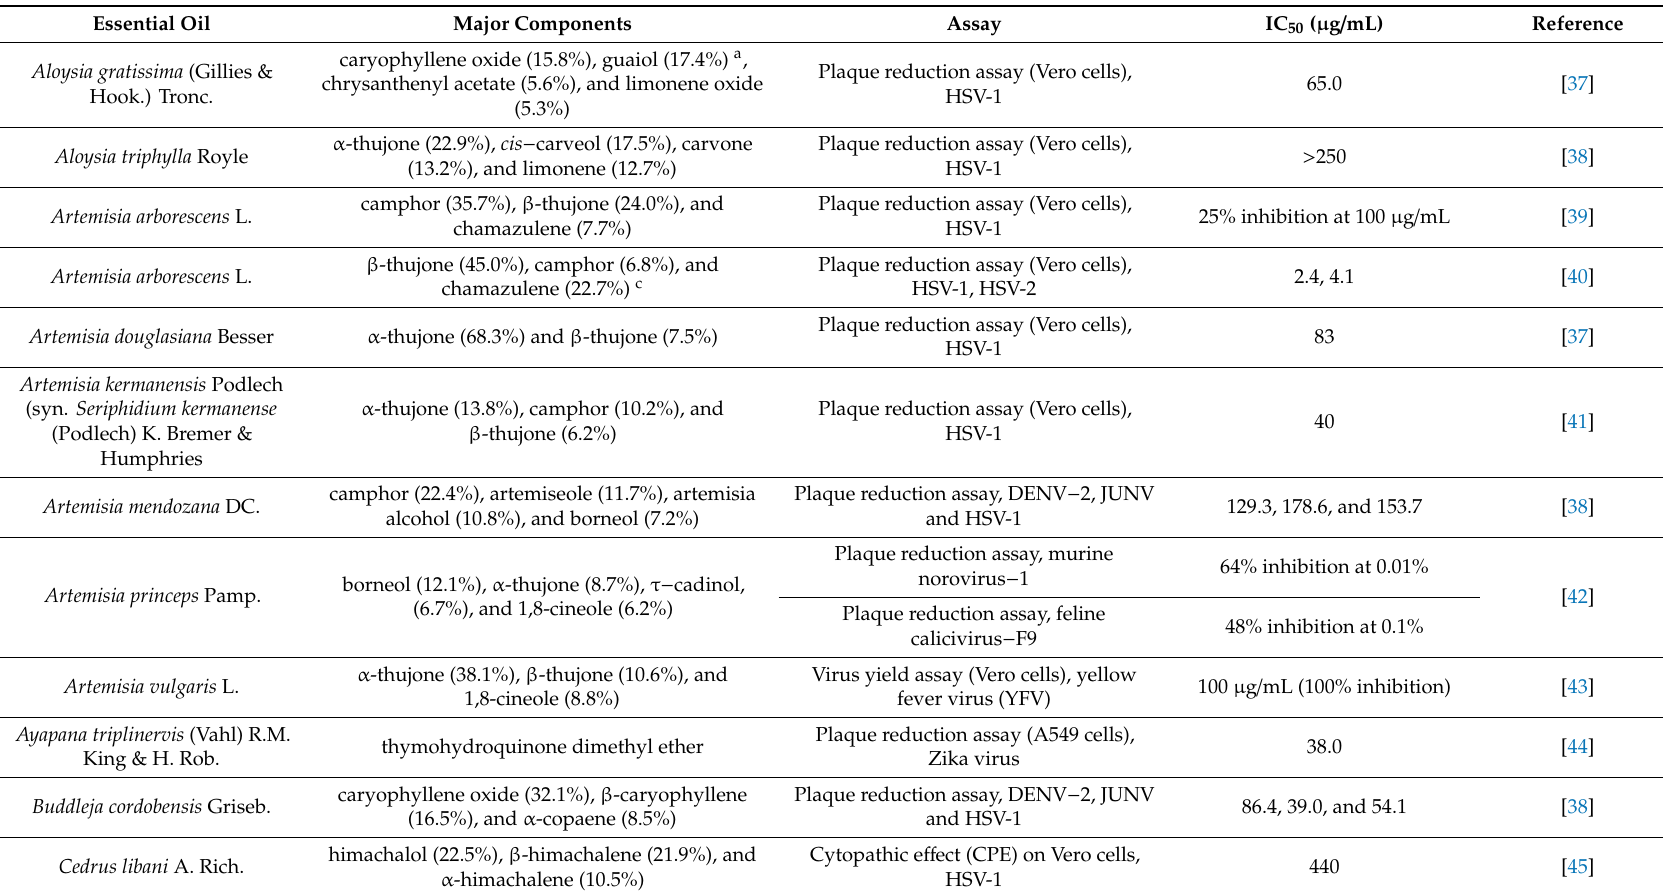
Table 1. Essential oils showing antiviral